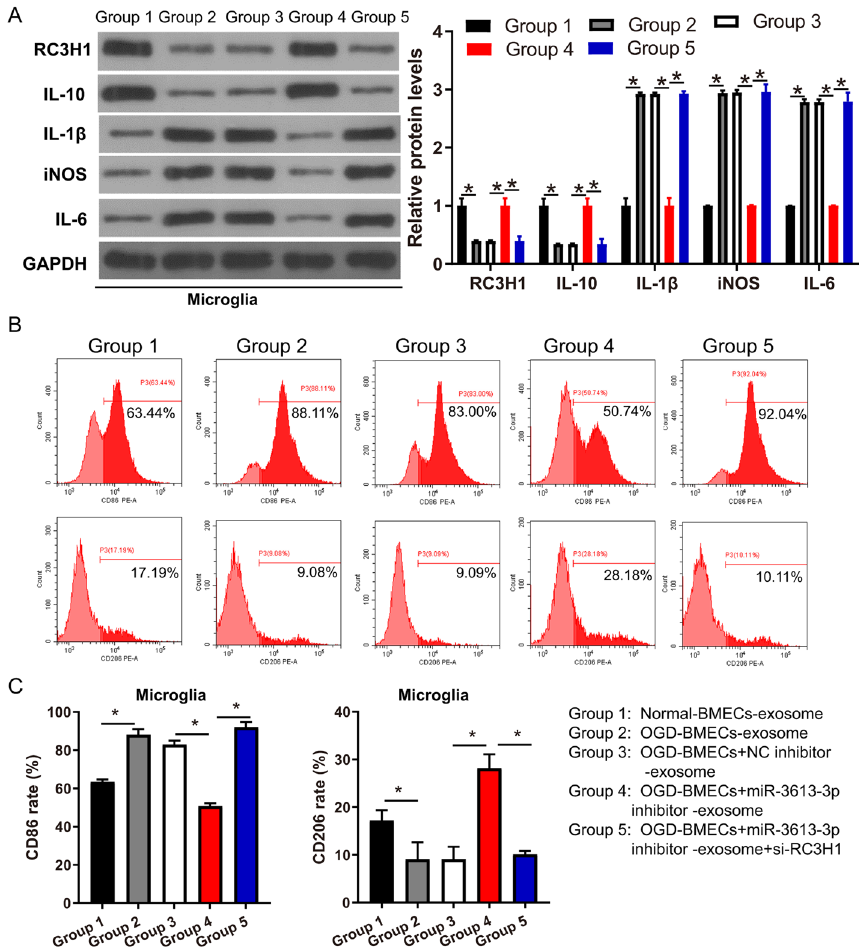
Fig. 3 BMEC exosomal miR-3613-3p promotes microglia M1 polarization via inhibiting RC3H1 expression. A Protein levels were measured by western blot. The relative protein level is shown. B After co-culture with BMEC exosomes, M1 (CD86) and M2 microglia (CD206) were detected by flow cytometry. Apoptotic representative images are shown. C The rate of M1 (CD86) and M2 microglia (CD206) is shown. Differences were analyzed using ANOVA, followed by post-hoc Dunnett’s multiple comparisons test. * p <